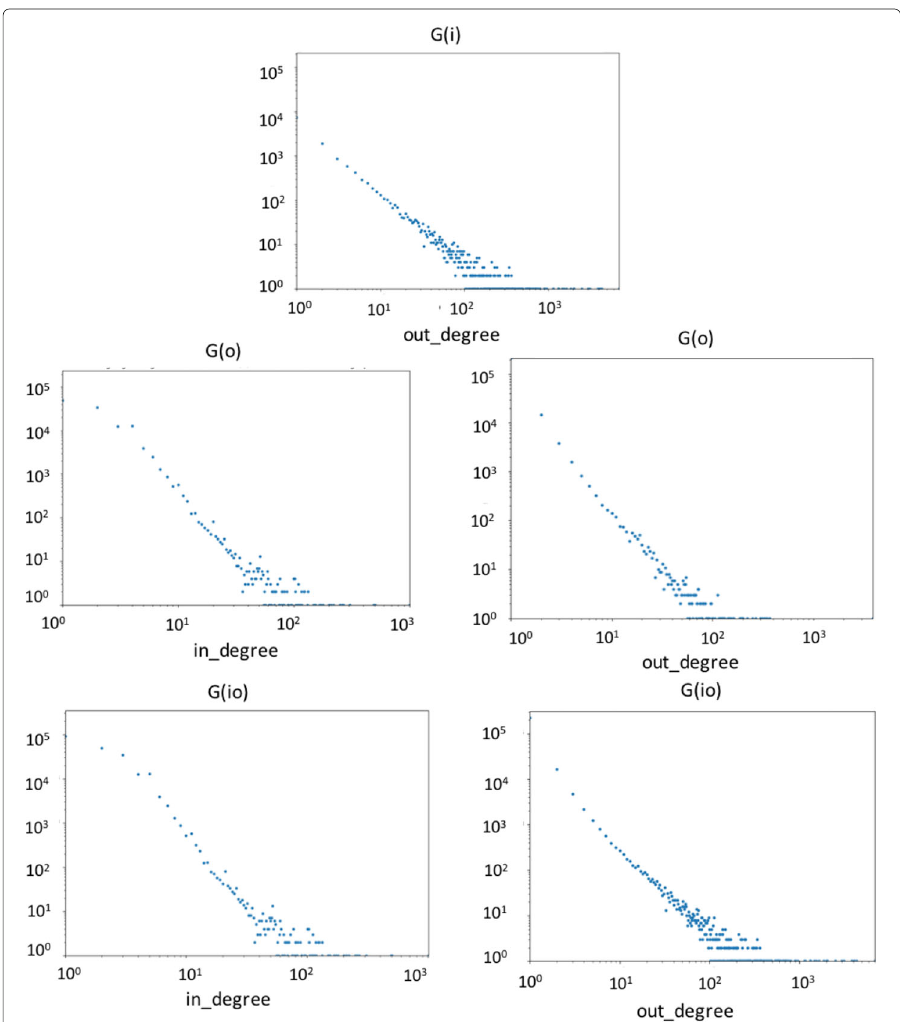
Fig. 5 In-degree and out-degree distributions (on a log-log scale) of G i , G o and G io . G i has a trivial in-degree distribution as nodes have either degree 1 or 0 with frequencies 213,634 and 14,074 respectively. For this reason, we do not reproduce it as a plot below. The y-axis represents the empirical frequency of the degree in all